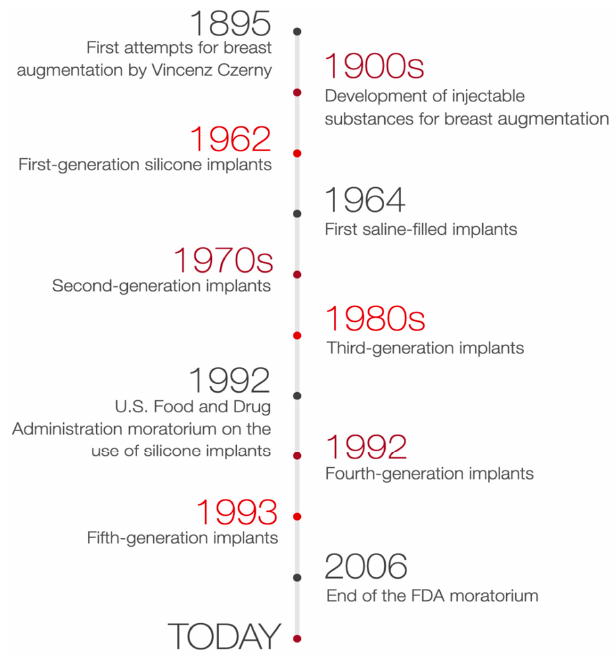
Figure 2. Timeline of breast augmentation